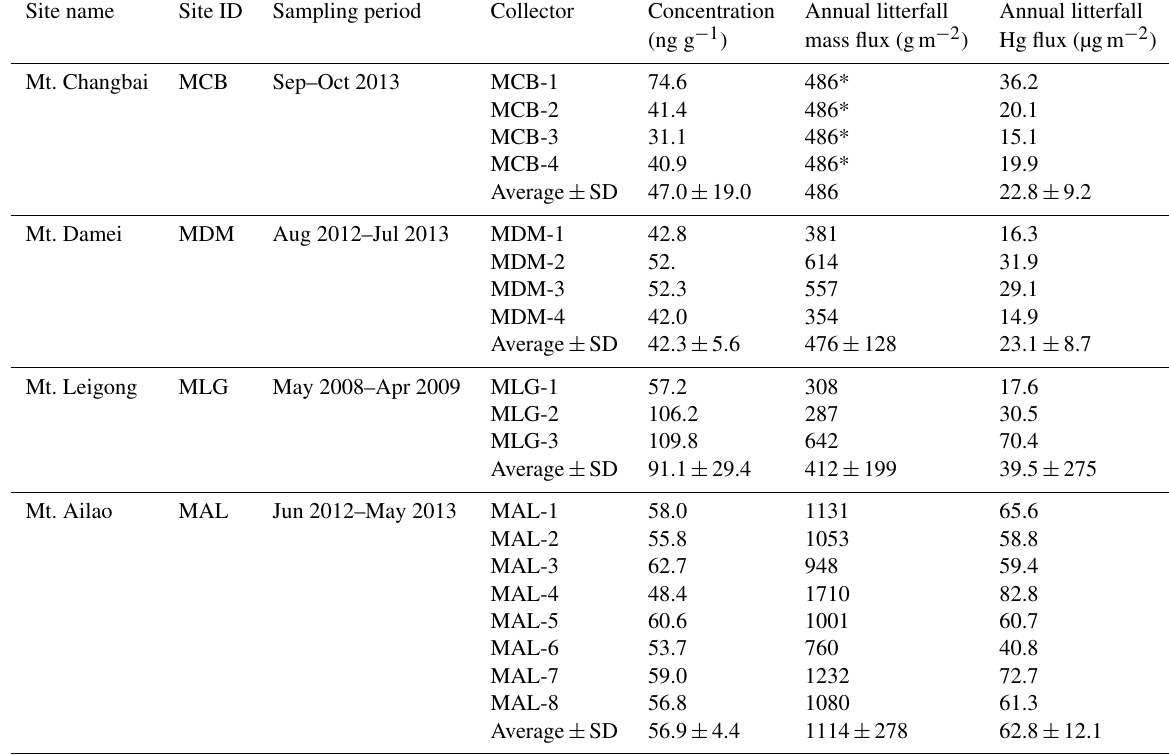
Table 2. Sampling site information, concentrations and annual litterfall deposition fluxes of Hg in litterfall at remote forest sites of